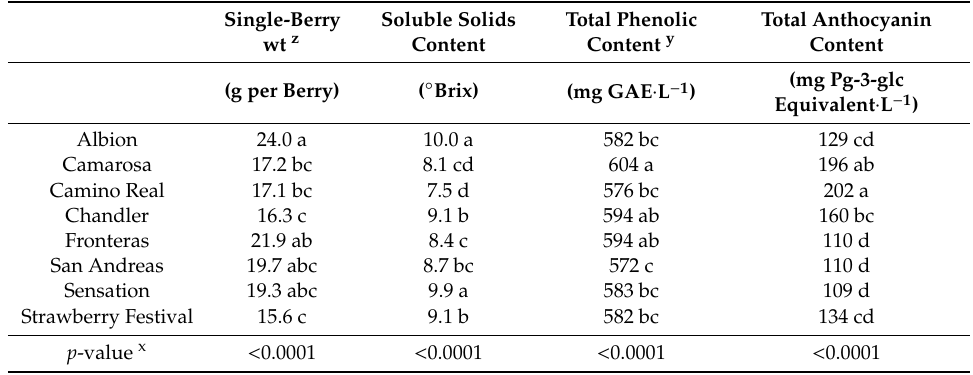
Table 5. Single-berry weight, fruit soluble solid content, total phenolic content, and total anthocyanin content of six June-bearing (“Camarosa”, “Camino Real”, “Chandler”, “Fronteras”, “Sensation”, and “Strawberry Festival”) and two day-neutral (“Albion” and “San Andreas”) strawberry cultivars grown in a high tunnel in Starkville, Mississippi from November 2017 to June